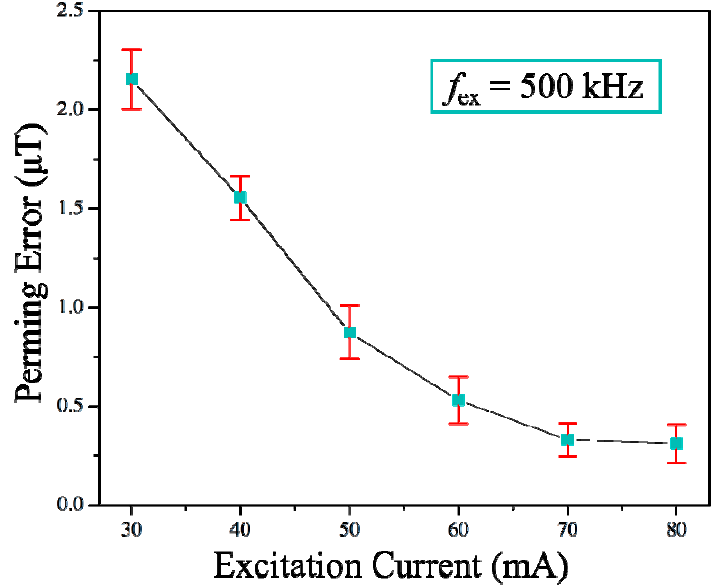
Figure 7. The perming error of the sensor as a function of excitation current magnitude.